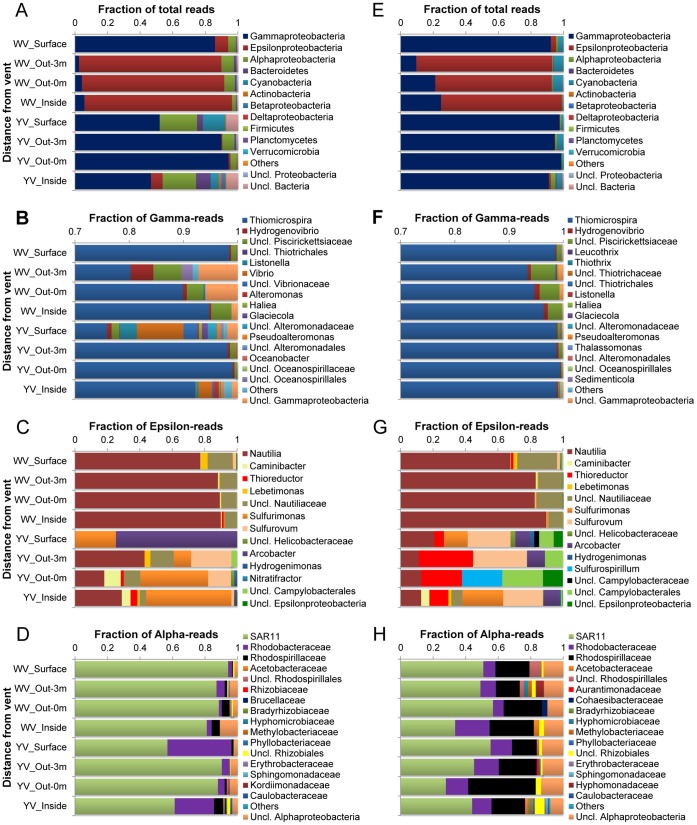
Distribution of tags by phylogenetic taxa among the bacterial DNA- (A-D) and RNA-based libraries (E-H).(A) and (E) Relative abundances of bacterial phyla or classes in total tags of each library. (B) and (F) Relative abundance of bacterial genera in total gammaproteobacterial tags. (C) and (G) Relative abundance of bacterial genera in total epsilonproteobacterial tags. (D) and (H) Relative abundance of bacterial families in total alphaproteobacterial tags.